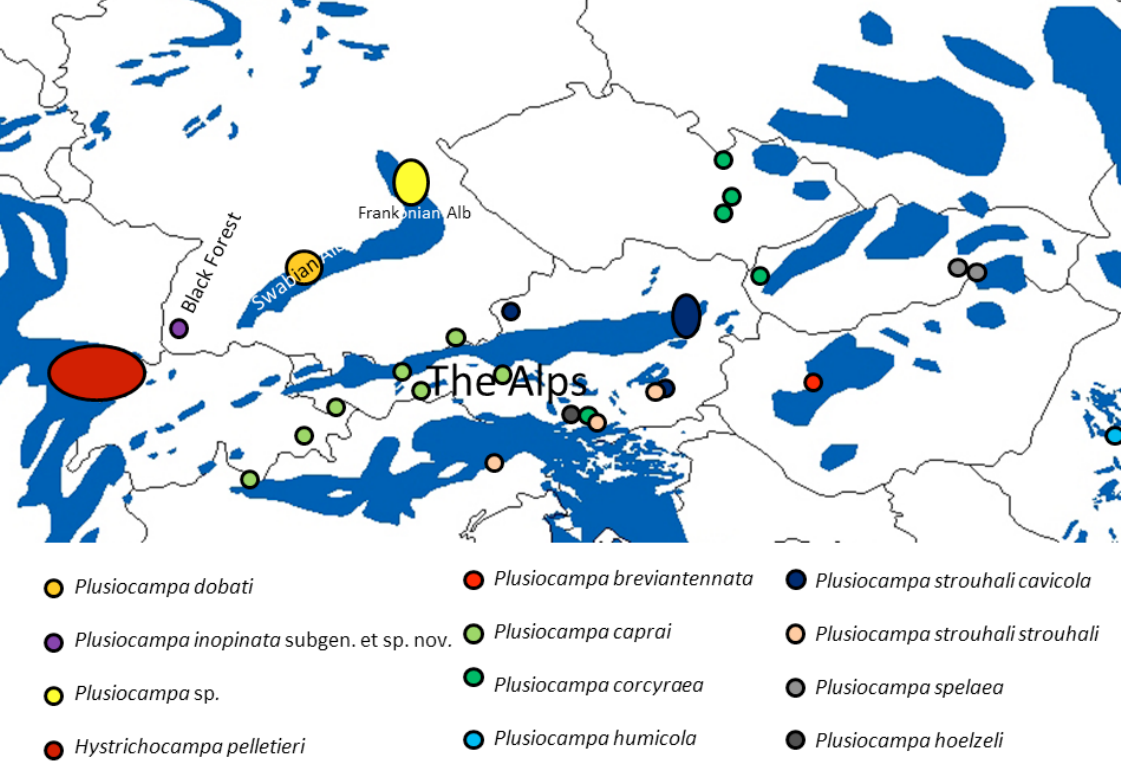
Fig. 26. Distribution of Plusiocampinae ( Plusiocampa Silvestri, 1912 and Hystrichocampa Condé, 1962) in Central Europe; blue indicates karst